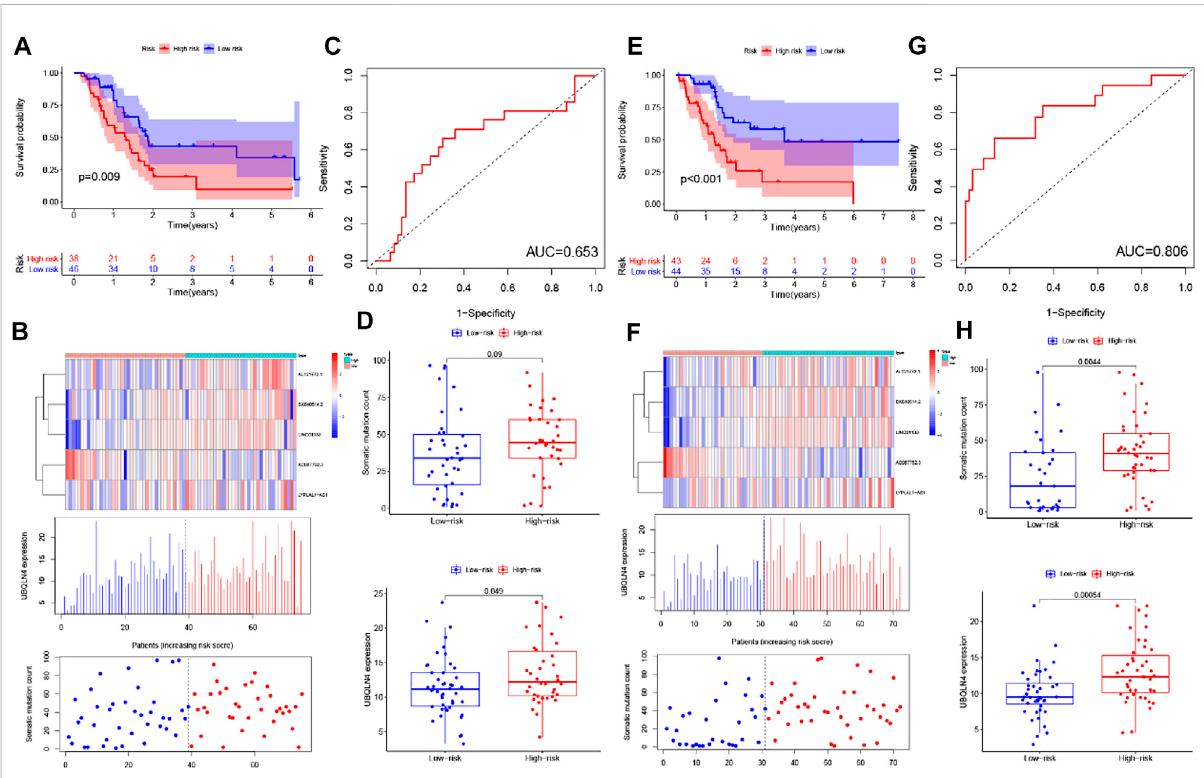
FIGURE 5 Identi fi cation and validation of the GILncSig for outcome prediction in patients with pancreatic cancer in the training set and testing set. (A,E) Kaplan – Meier survival curves of patients in the high- and low-risk groups are separated by the median GILncSig score in the training set (A) and testing set (E) . (B,F) LncRNA expression patterns and the distribution of somatic mutation and UBQLN4 expression with increasing GILncSig score in thetraining set (B) andtestingset (F) . (C,G) Time-dependentROCcurvesfor 1-yearsurvivalpredictionoftheGILncSig inthetrainingset (C) and testing set (G) . (D,H) Boxplots of comparison of thesomatic mutationcounts and theUBQLN4expressionbetween thehigh- and low-risk groups in the training set (D) and testing set (H)